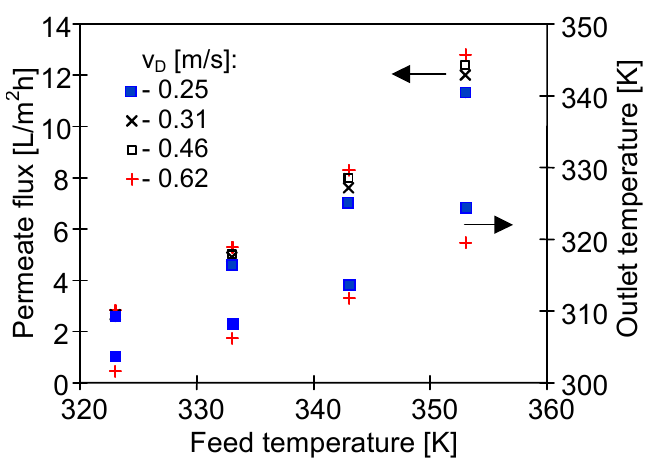
Figure 7. The influence of feed temperature and the distillate flow rate on the permeate flux and distillate outlet temperature. T Din = 293 K. Mode 1. Module SMD2.